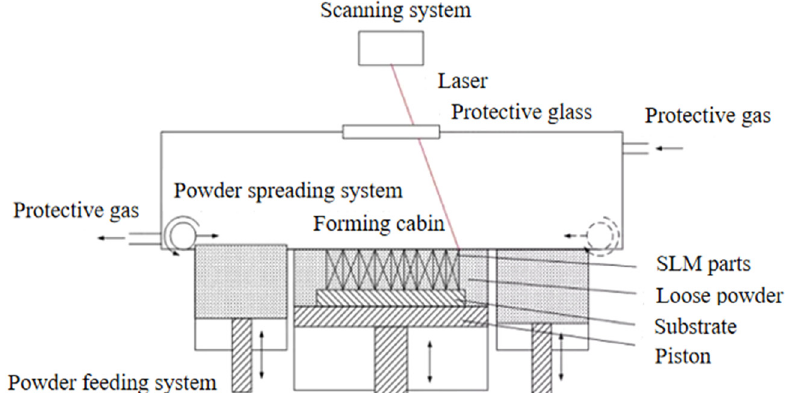
Figure 7: SLM forming schematic diagram.